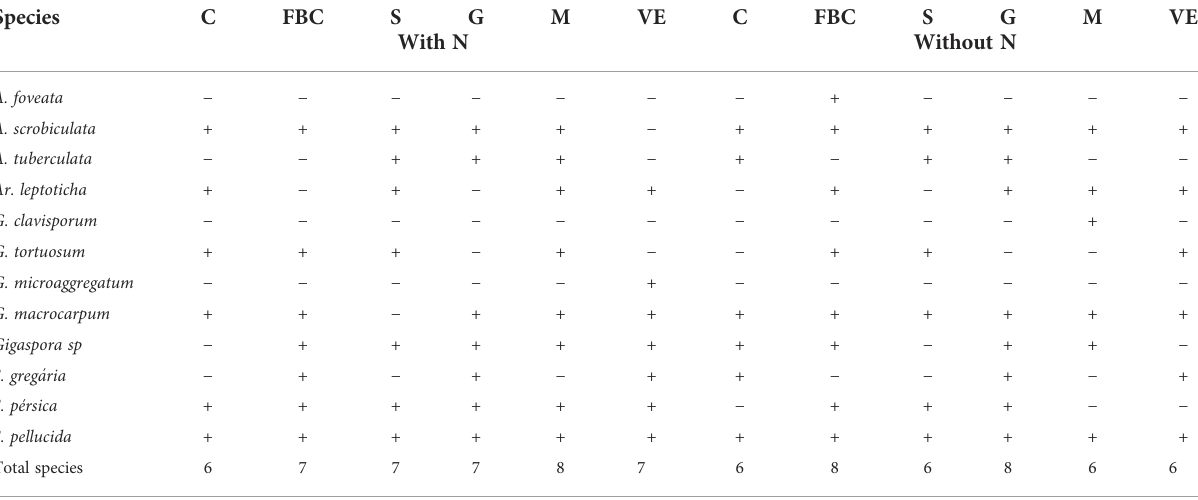
TABLE 5 Species of arbuscular mycorrhizal fungi found in the rhizosphere of Crotalaria (C), wild bean from Ceara ́ (FBC), sorghum (S), Guandu ́ (G), millet (M) and spontaneous vegetation (VE) with and without addition of nitrogen in planting straight into the savannah. Species C